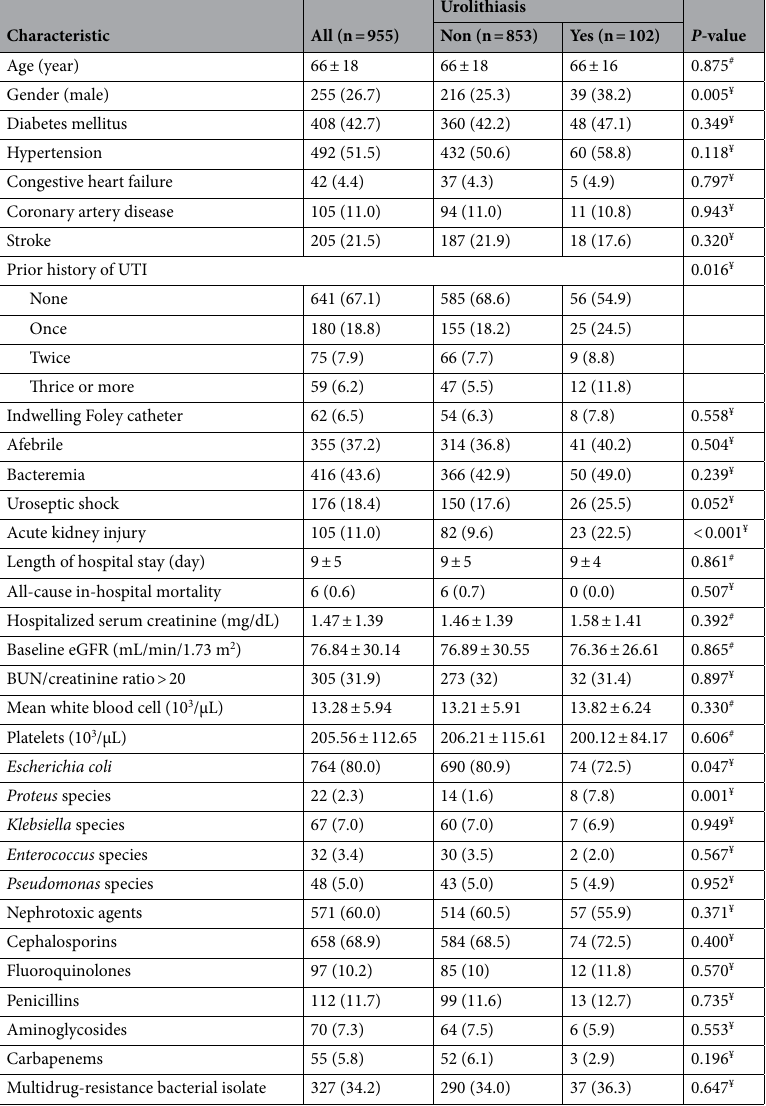
Table 4. Characteristics of hospitalized urinary tract infection patients without hydronephrosis with respect to urolithiasis. Data are expressed as mean ± SD or number (percentage) # Student T-test; ¥ Chi-Square test or Fisher’s exact test. UTI urinary tract infection, eGFR estimated glomerular filtration rate, BUN blood urea